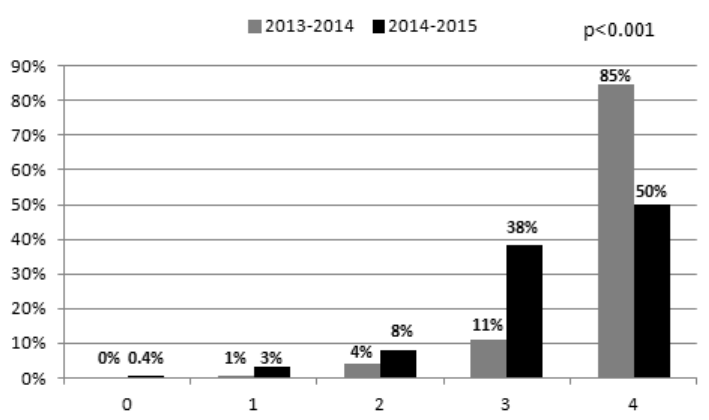
Figure 2. Technical handling of tools in the e-learning portal